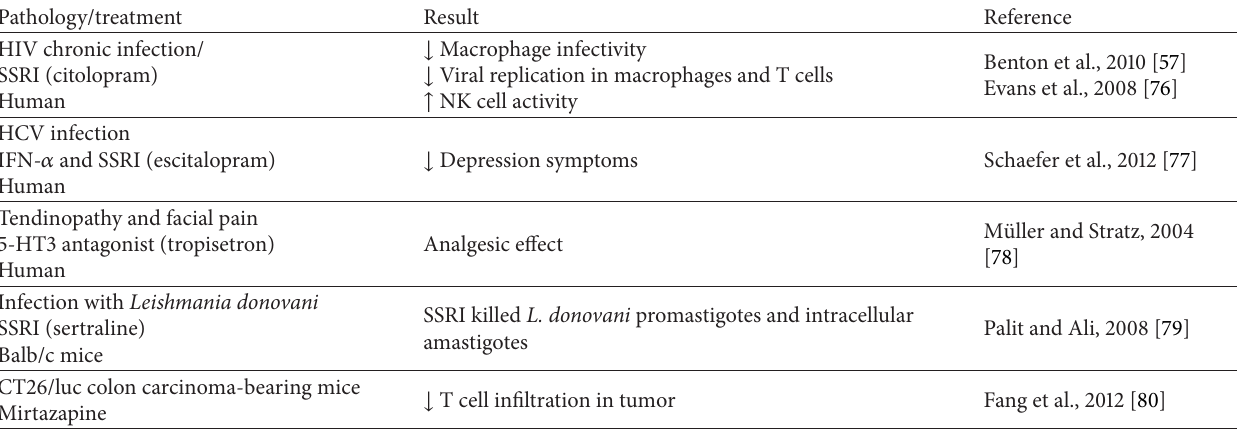
Table 4: Serotonergic drugs and their effects on the immune